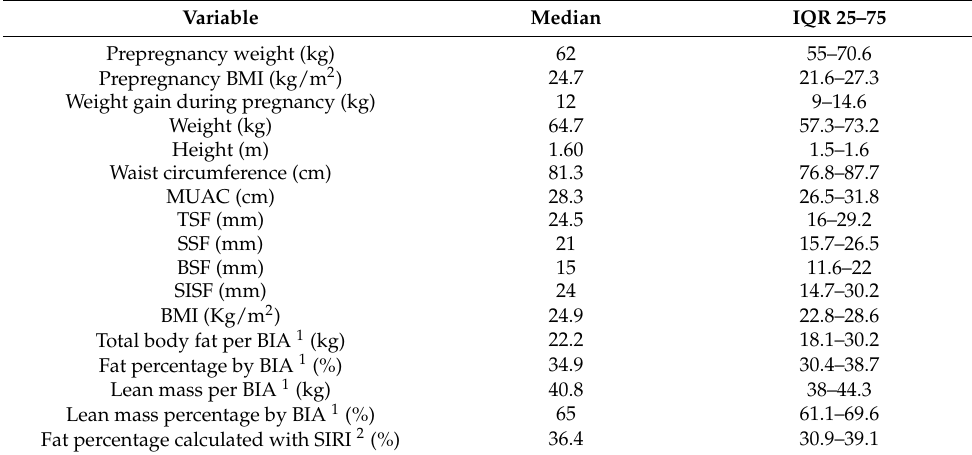
Table 2. Anthropometric variables of nursing mothers ( n =